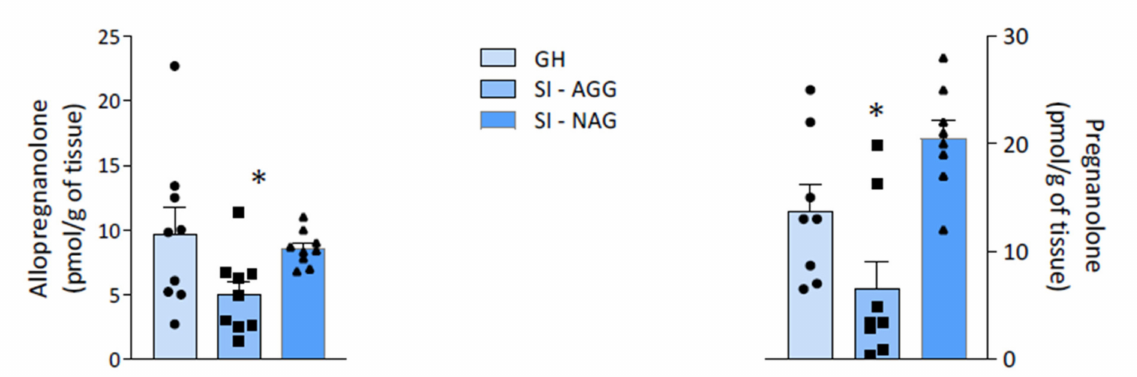
Figure 5. The levels of allopregnanolone (Allo) and pregnanolone (PA) in the hippocampus of SI and GH mice. A significant decrease in both Allo and PA levels was found in the hippocampus of SI-AGG mice (unpaired t test: Allo = * p = 0.04, t = 2.18, df = 16; PA = * p = 0.04, t = 1.78, df =